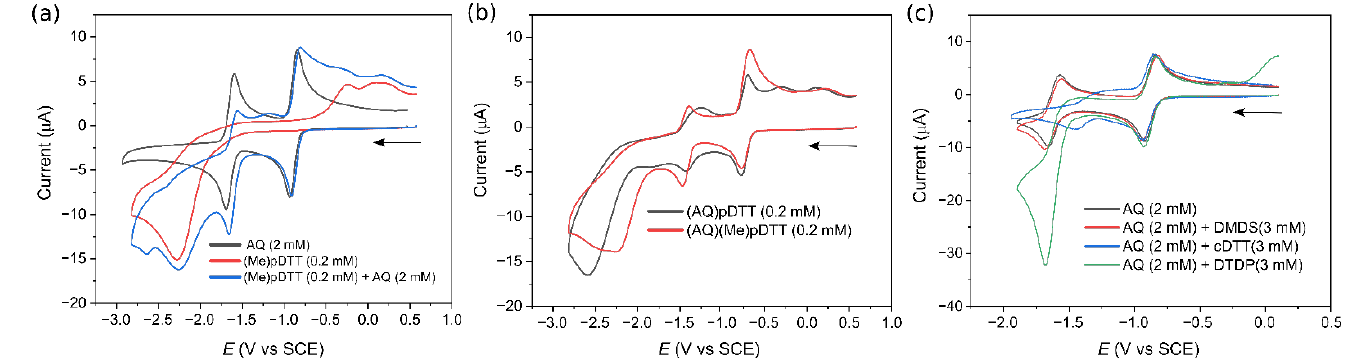
Figure 5. Cyclic voltammograms recorded at a 1 mm GC disk electrode using a sweep rate of 1 V s − 1 on ( a ) AQ (black), (Me)pDTT (red), and AQ/(Me)pDTT (blue), ( b ) (AQ)pDTT (black) and (AQ)(Me)pDTT (red), and ( c ) AQ (black), AQ/DMDS (red), AQ/cDTT (blue), and AQ/DTDP (green) in 0.1 M Bu 4 NBF 4 /DMF. Arrows indicate scan direction from the resting potential. Reduction of AQ takes place as two Nernstian one-electron transfer processes at − 0.9